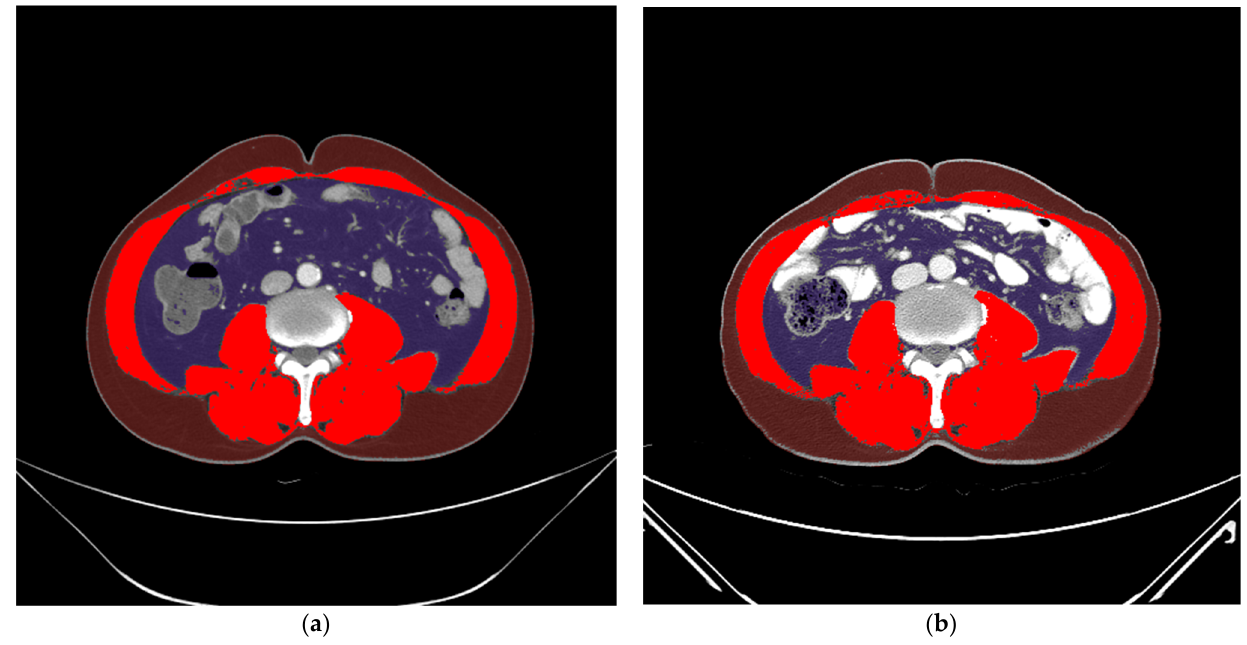
Figure 1. Example of body composition measurement using automated artificial intelligence software. Skeletal muscle area (red), subcutaneous fat area (brown), and visceral fat area (purple) decreased ( b ) one year after gastrectomy compared to ( a ) before surgery.